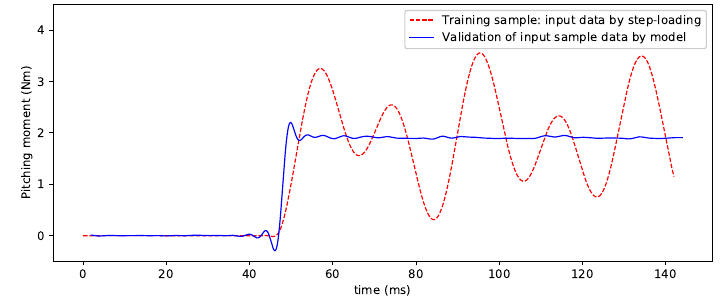
Figure 11. Input sample data and validation by CNN model (pitching moment).